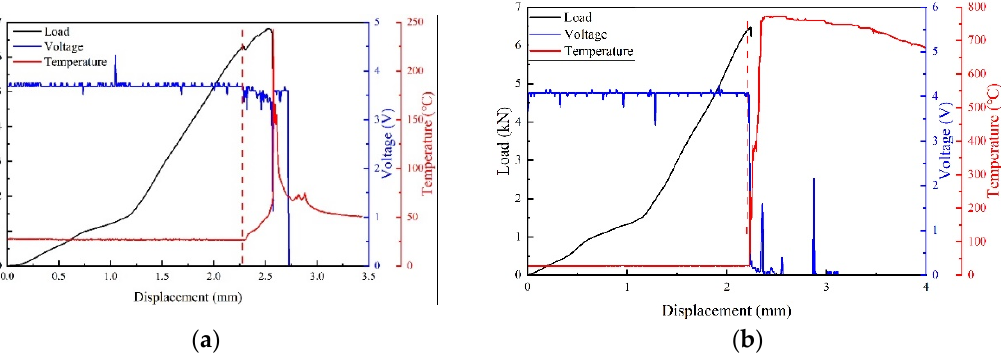
Figure 8. Load, voltage, and temperature–displacement curves of batteries with different SOCs: ( a ) 40%; ( b ) 80%.